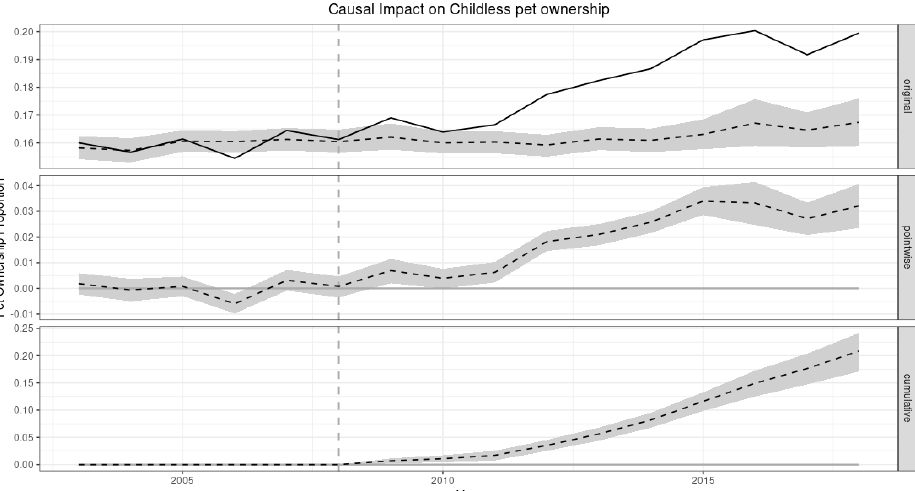
Figure 3. Causal impact on childless pet ownership. The first panel shows the actual data (solid line) and a prediction for what would have happened if the crisis had not occurred (dotted line). The second panel shows the pointwise causal effect, which is the difference between the actual data and the counterfactual predictions estimated by the model (dotted line). The third panel shows the cu- mulative pointwise causal effect (dotted line). The grey area refers to the 95% standard deviation boundaries.